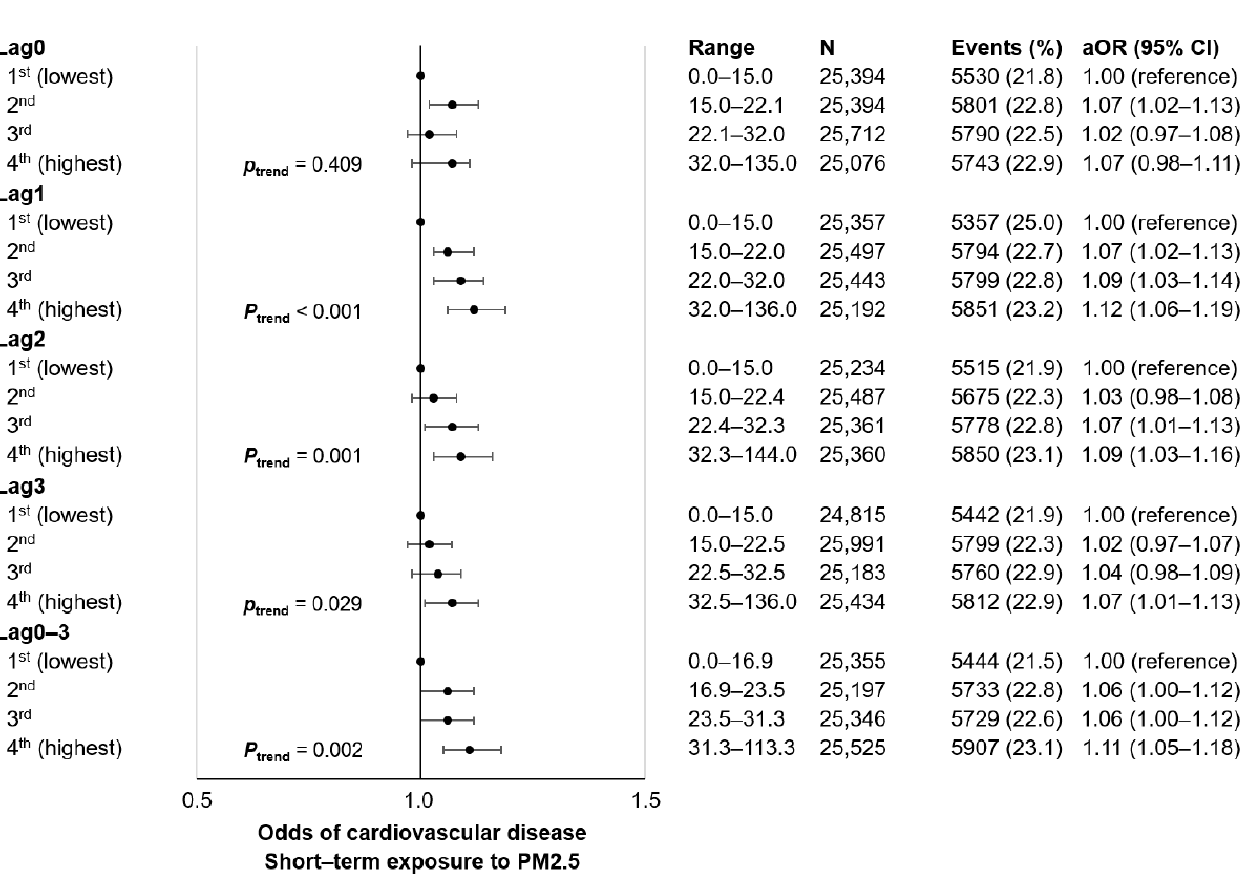
Figure 2. Association of short-term exposure to PM2.5 with cardiovascular disease events among 5-year cancer survivors. Adjusted odds ratio calculated by conditional logistic regression after adjustment for mean daily temperature (categorical, 1st, 2nd, 3rd, and 4th quartiles). Acronyms: N, number of participants; aOR, adjusted odds ratio; CI, confidence interval; PM, particulate matter.